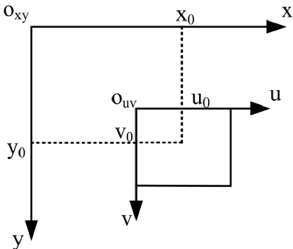
( b ) Border position Figure 5. Images of the actual situation.